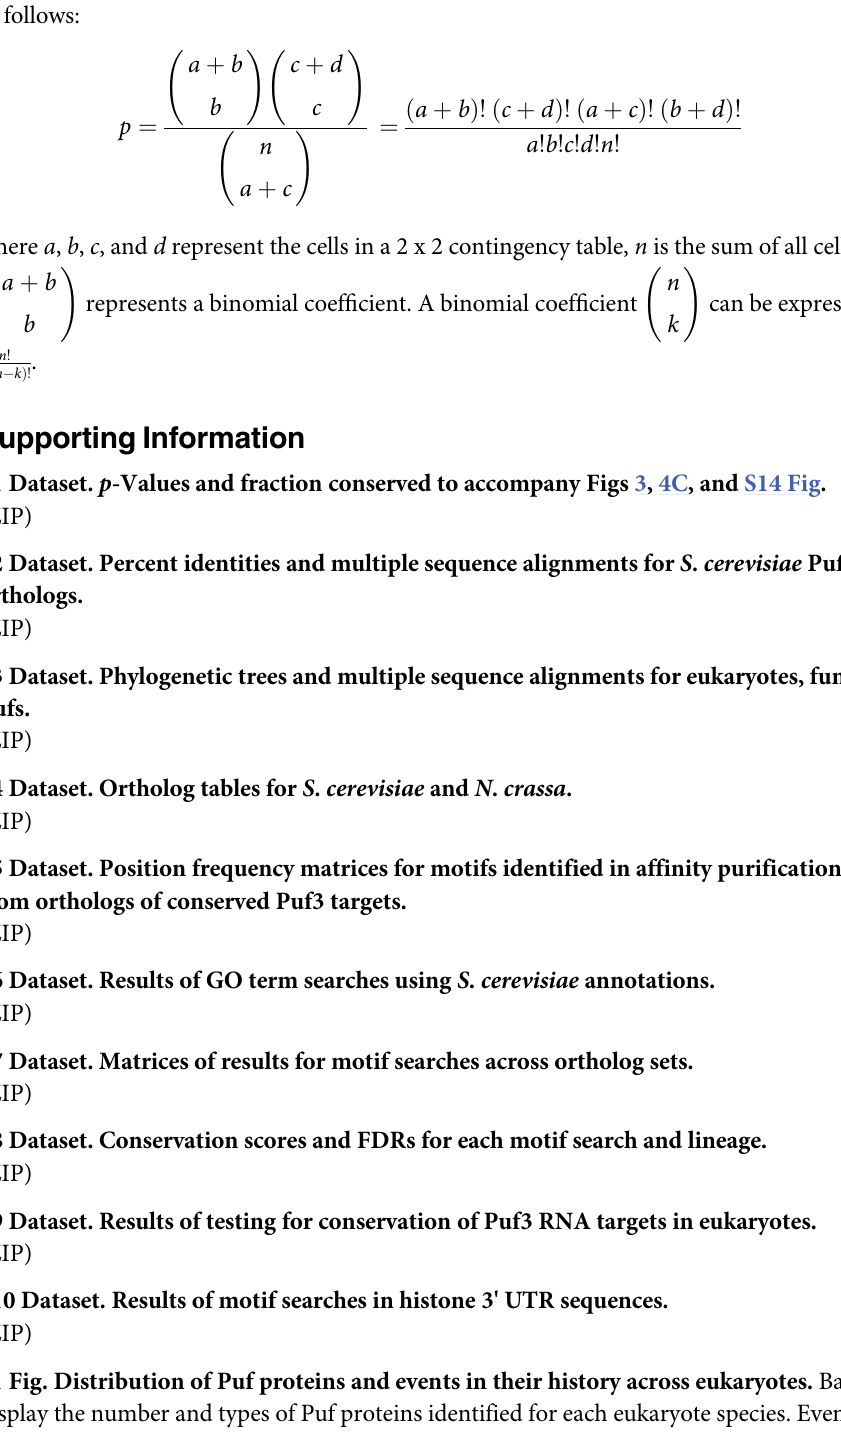
S1 Fig. Distribution of Puf proteins and events in their history across eukaryotes.